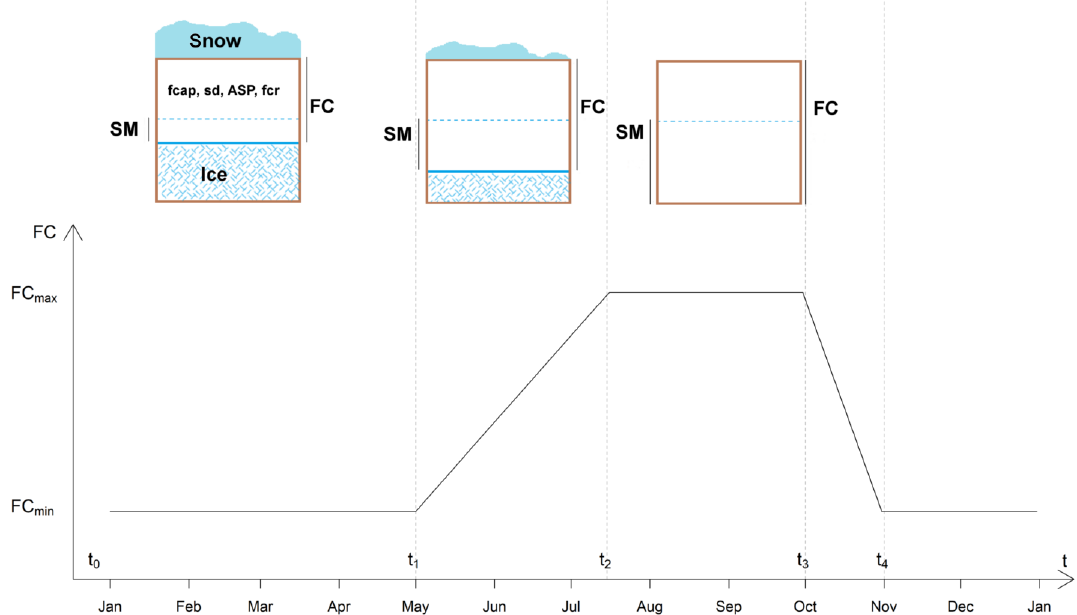
Figure 2. Field capacity (FC) parameter set to be time-variable. FC is set to a minimum value (FC min ) when t < t 1 or t > t 4 , with t increasing linearly between t 1 and t 2 up to the maximum value FC max and linearly decreasing between t 3 and t 4 . The top image is a schematic representation of a soil cell to help visualize the variable FC. FC is dependent on the soil parameters: fcap (volumetric field capacity), sd (soil depth), ASP (aspect) and fcr (field capacity rate; calibrated parameter).